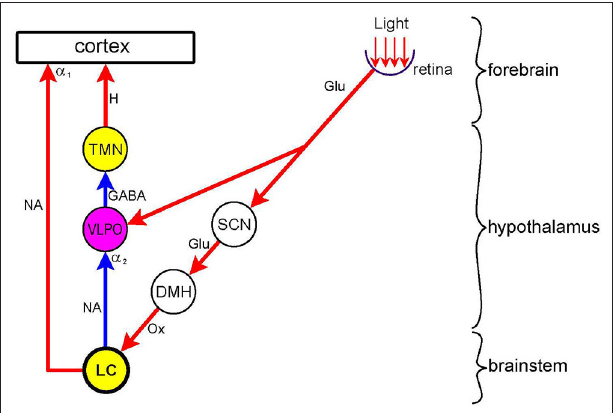
FIGURE 4 | Dual effect of light on arousal Nuclei : wake-promoting (yellow)–LC (locus coeruleus); TMN (tuberomamillary nucleus); sleep-promoting (purple)–VLPO (ventrolateral preoptic nucleus; relay (white)–SCN (suprachiasmatic nucleus); DMH (dorsomedial hypothalamus. Connections are shown by arrows: red–excitatory; blue–inhibitory. Neurotransmitters : Glu (glutamate); GABA (y-amino-butyric acid); Ox (orexin); H (histamine); NA (noradrenaline). Adrenoceptors (postsynaptic): α 1 (excitatory), α 2 (inhibitory). Light exerts a sleep-promoting effect by directly stimulating the sleep-promoting nucleus VLPO. This effect is largely mediated by inhibition of the wake-promoting nucleus TMN. Light also exerts a wake-promoting effect by indirectly stimulating, via the SCN and DMH, the wake-promoting nucleus LC. This effect is mediated by the direct stimulation of the cerebral cortex and the inhibition of the VLPO, thereby disinhibiting the wake-promoting TMN. In nocturnal animals the sleep-promoting, and in diurnal animals